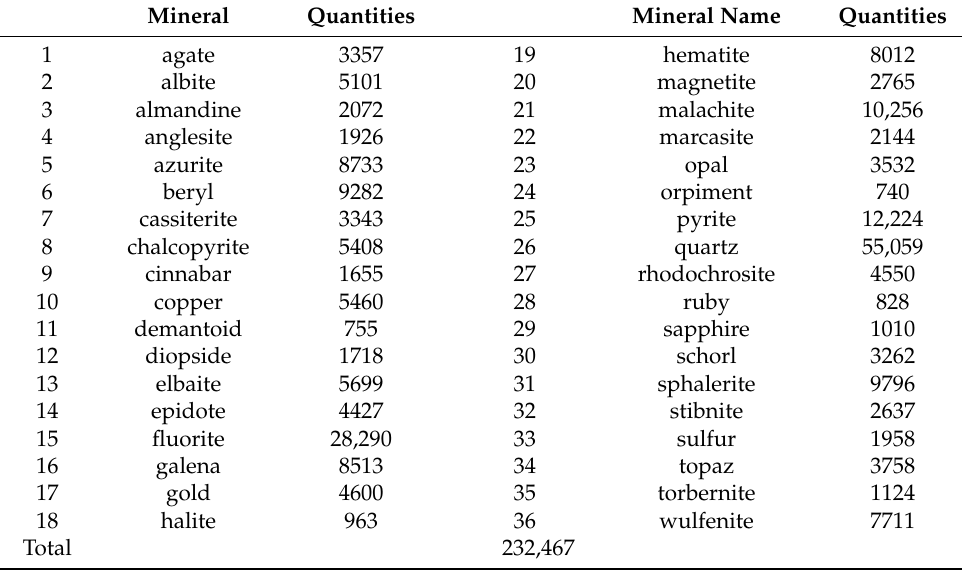
Table 2. Mineral names and the number of labels for each mineral. Mineral